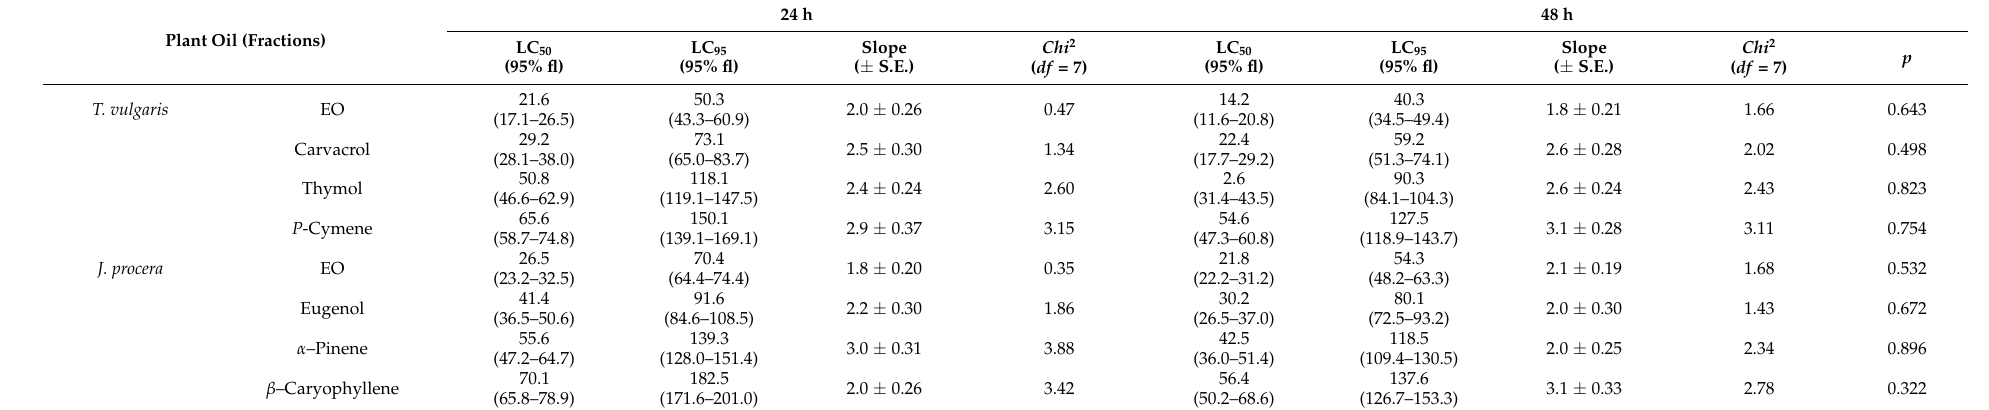
Table 5. Fumigant adulticidal activity ( µ L/L) of the tested plant oils and their major terpenes against T. granarium